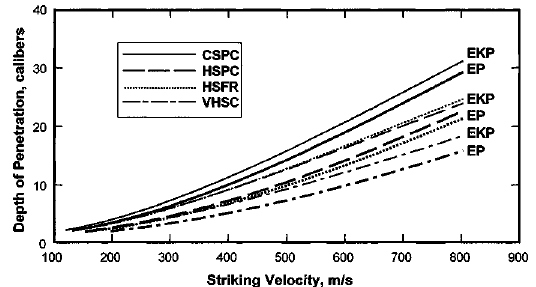
Fig. 7. Comparison of calculations using the elastic-cracked-plastic (EKP) and elastic-plastic (EP) versions of the spherical-cavity ex- pansion